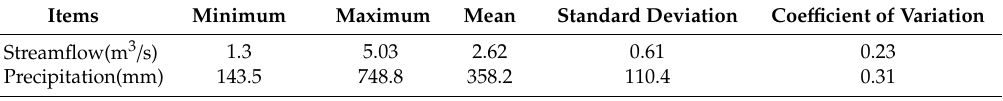
Table 2. Statistical values of Hailiutu River Basin for annual average streamflow and precipitation.